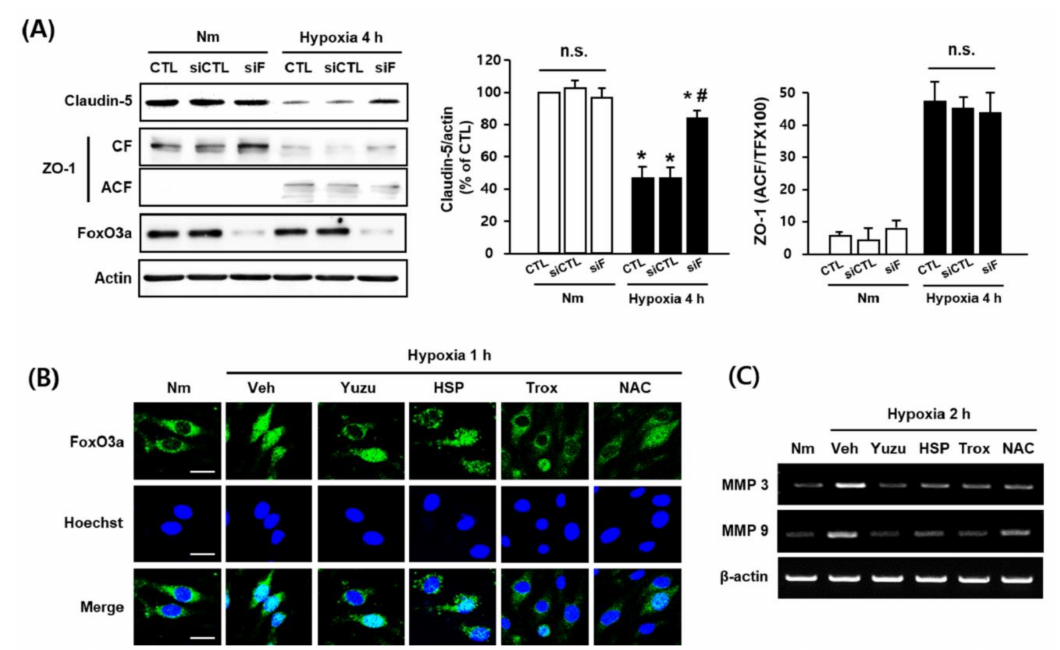
Figure 5. Protective e ff ects of yuzu and hSP on FoxO3a / MMP-mediated claudin-5 degradation via antioxidant activity in bEnd.3 cells. ( A ) E ff ect of FoxO3a silencing on claudin-5 and ZO-1. Quantitative analysis of degradation of claudin-5 and redistribution of ZO-1 in bEnd.3 cells; bEnd.3 cells were transfected with siRNA control (siCTL) or siRNA FoxO3a (siF), as described in the Materials and Methods. The siCTL- or siF-transfected bEnd.3 cells were incubated for 4 h under normoxia or hypoxia. Samples were lysed and immunoblotted for claudin-5, ZO-1 (CF and ACF), FoxO3a, or actin; n = 5, data are shown as mean ± SEM, * p < 0.05 vs. nm, # p < 0.05 vs. siCTL of hypoxia. ( B ) Immunofluorescent staining of FoxO3a (green) and hoechst (blue) in bEnd.3 cells. Scale bar, 20 µ m; n = 4. ( C ) Expression of mMP-3 / 9 mRNA levels in bEnd.3 cells. The mRNA levels of mMP-3 / 9 were measured at hypoxia, 2 h in the absence or presence of yuzu, hSP, Trolox, or NAC. nm, normoxia; Veh, vehicle; hx, hypoxia; hSP, hesperidin; CF, cytosolic fraction; ACF, actin cytoskeletal fraction; siCTL, siRNA control; siF, siRNA FoxO3a; Trox,